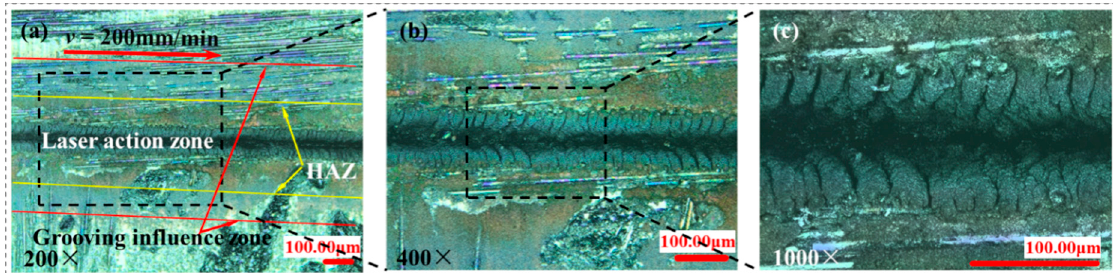
Figure 10. The grooved morphologies with repetition frequency of 10 kHz and laser power of 14 W: ( a ) 200 × magnifications; ( b ) 400 × magnifications; ( c ) 1000 × magnifications.